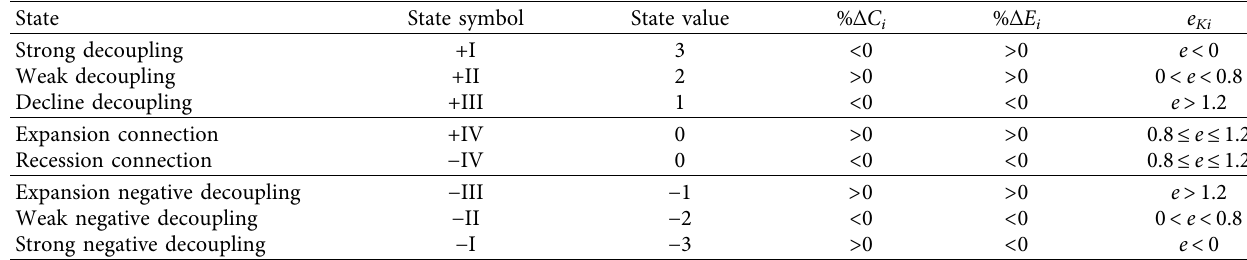
Table 3: Analysis model of decoupling state of energy structure.